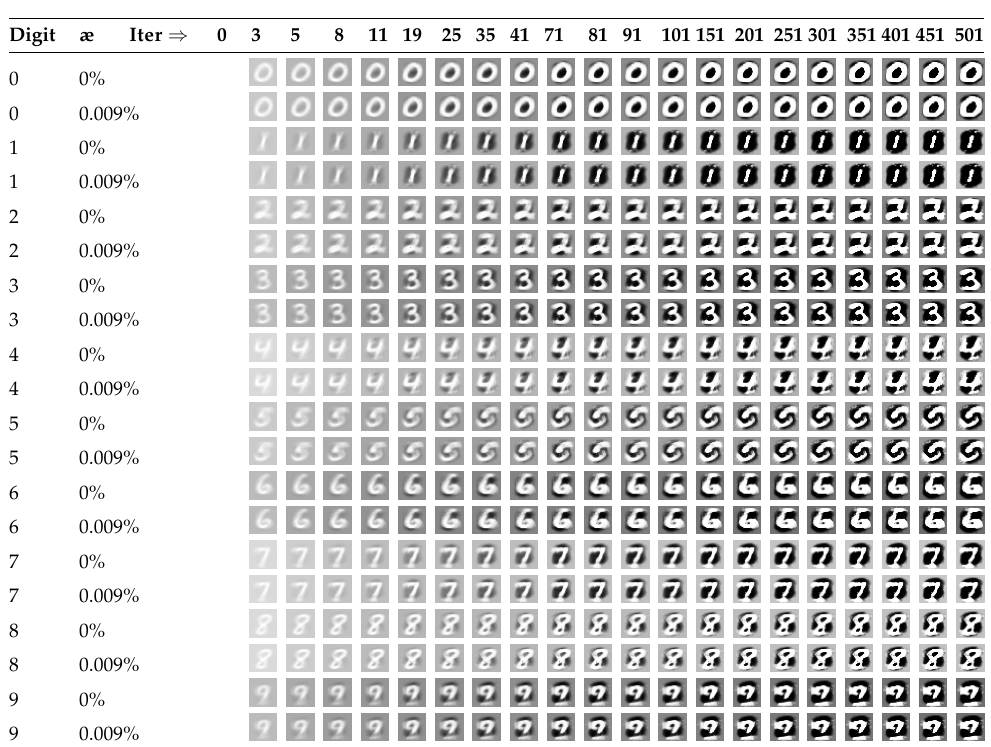
Table 3. Intuitive multiple binary valued cue recall (MBVCR) observations with RAN model of MNIST data.